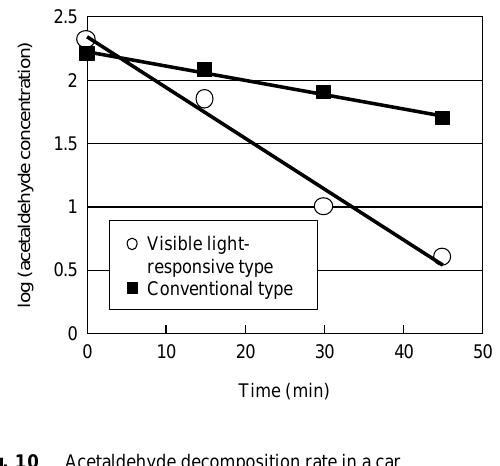
Acetaldehyde decomposition rate in a car Fine weather: under sunlight, sample size: 100 cm 2 (A 3-L glass cell was placed directly below the wind-